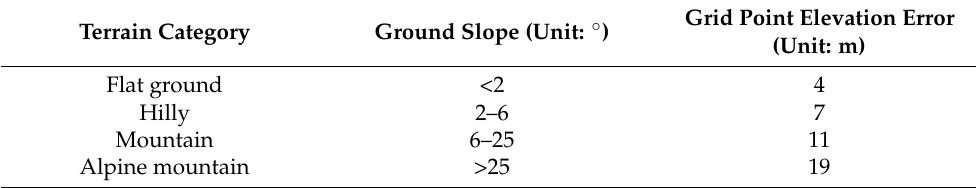
Table 4. 1:50,000 DEM accuracy standard.